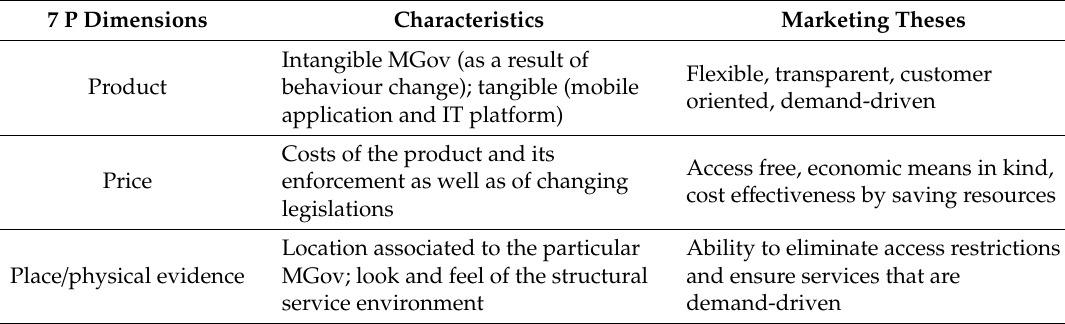
Table 4. Marketing of MGov for upstream audience in the context of marketing